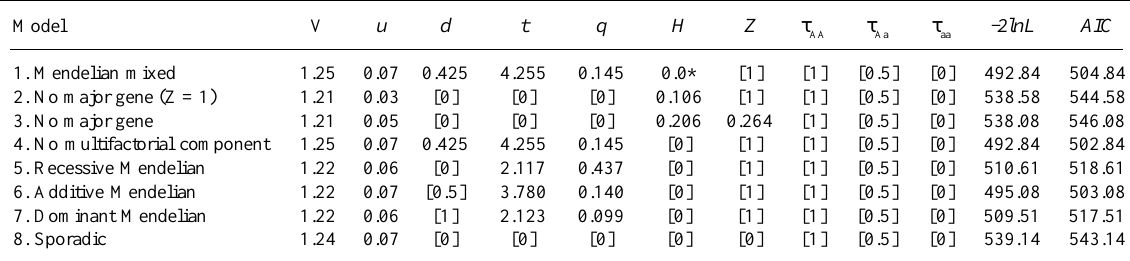
Table IV - Segregation analysis of eosinophil levels among parasitized individuals.